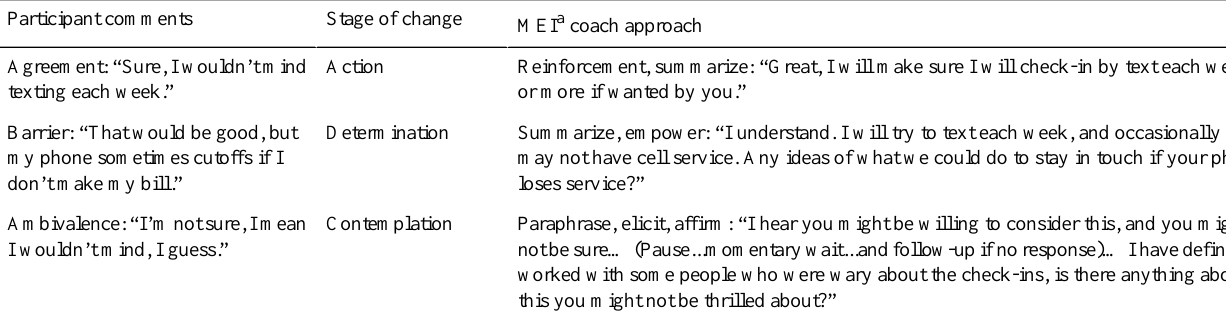
Table 1. Motivational interviewing approaches to address level of interest in telephonic engagement.